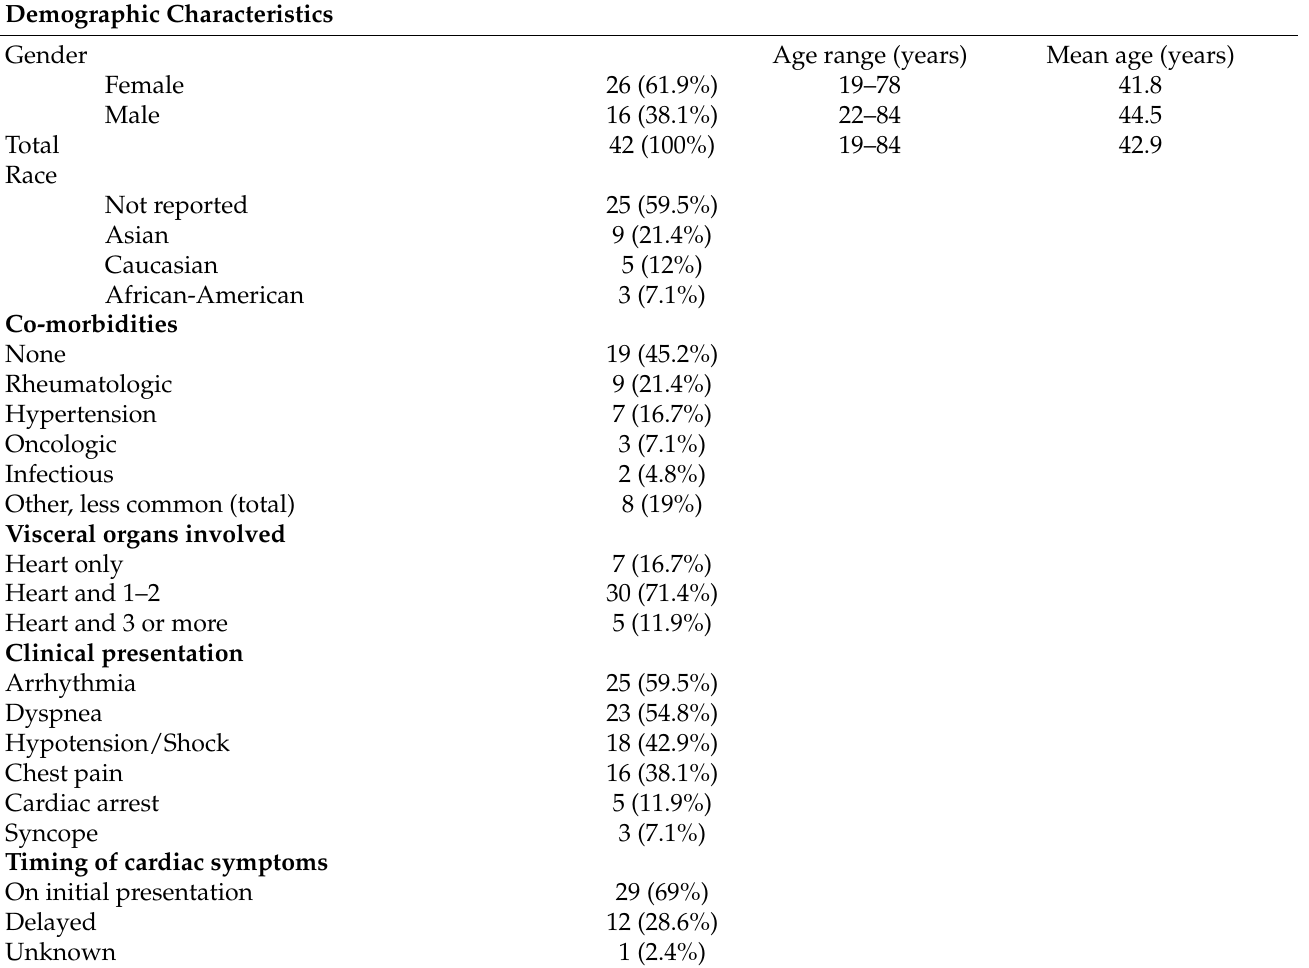
Table 1. The epidemiology, demographics, clinical presentation, diagnostic findings, and outcome in DRESS syndrome